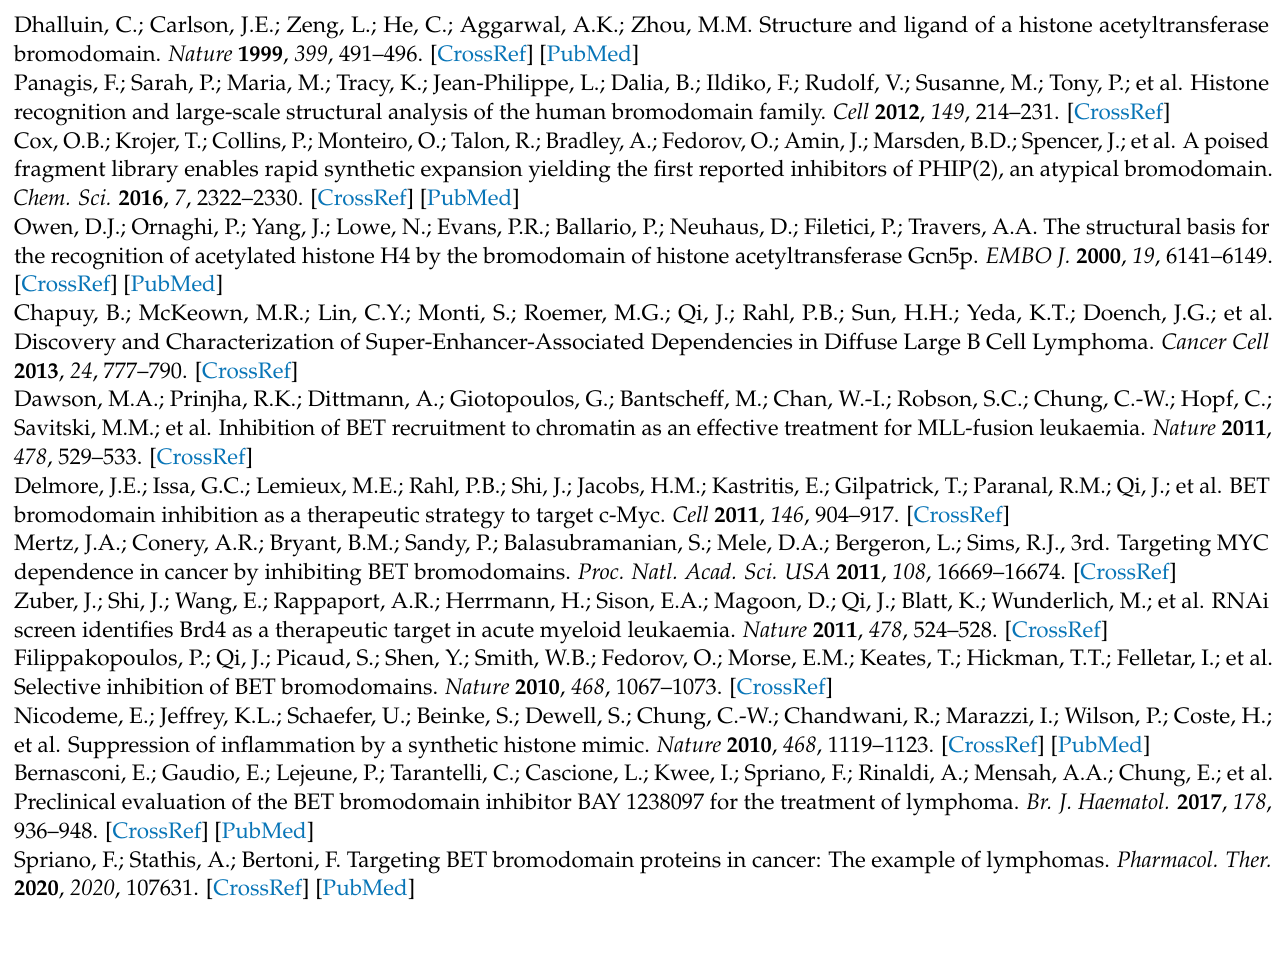
4 Microarray; Table S3: DG-75 Microarray; Table S4: platform comparison; Table S5: RNAseq Gene Intersection; Table S6: GO terms; Table S7: GO + DEG; Table S8: GO intersections; Table S9: GO significant